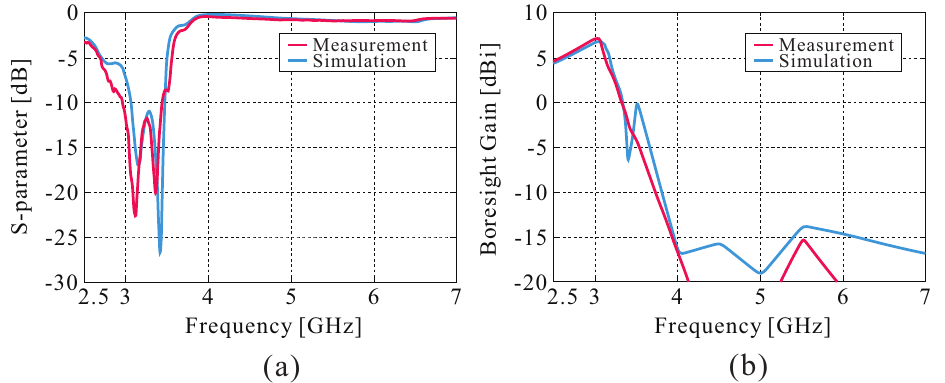
Figure 8. Measurement results of the fabricated antenna and the simulation. ( a ) The reflection coefficient and ( b ) the boresight